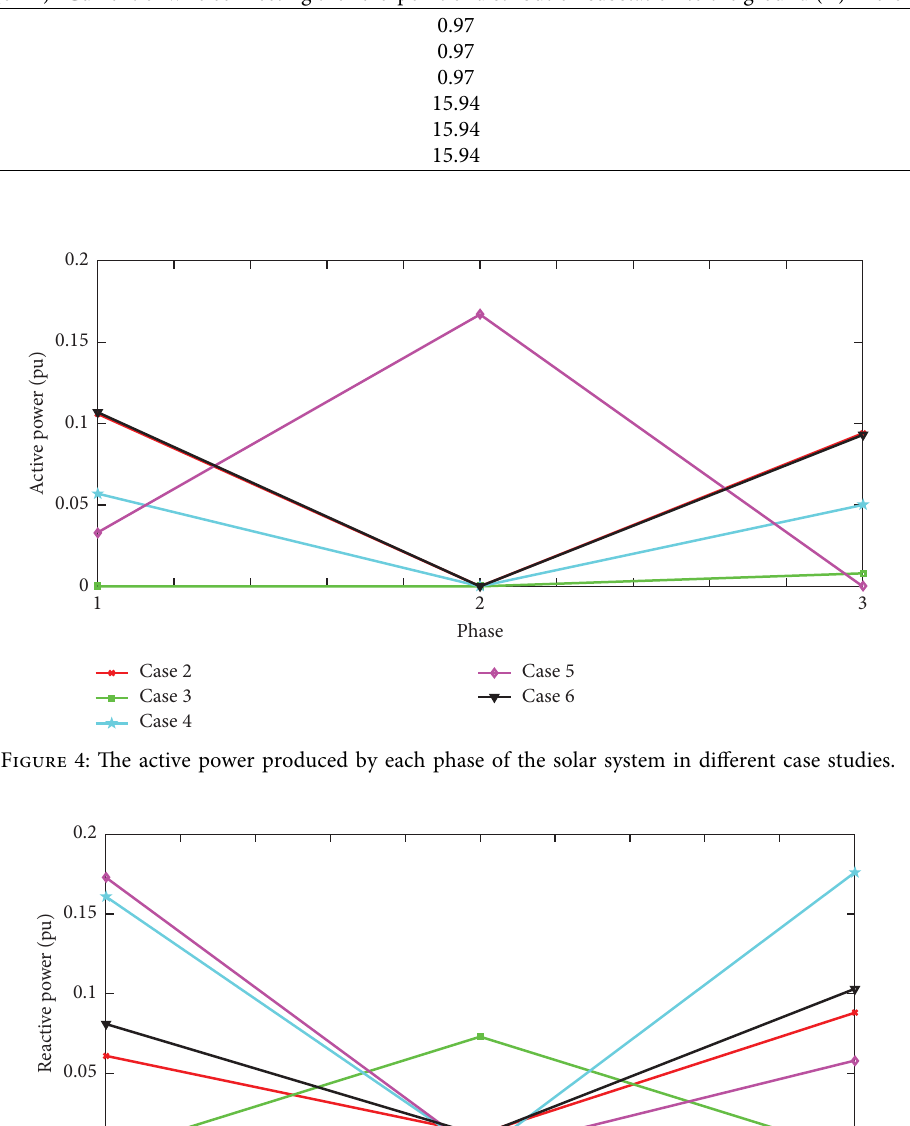
Table 6: Investigating the efects of zero-point impedance on characteristics of zero-point of the distribution substation. Case Impedance (ohm) Current of wire connecting the zero-point of distribution substation to the ground (A) Zero-point voltage (V)